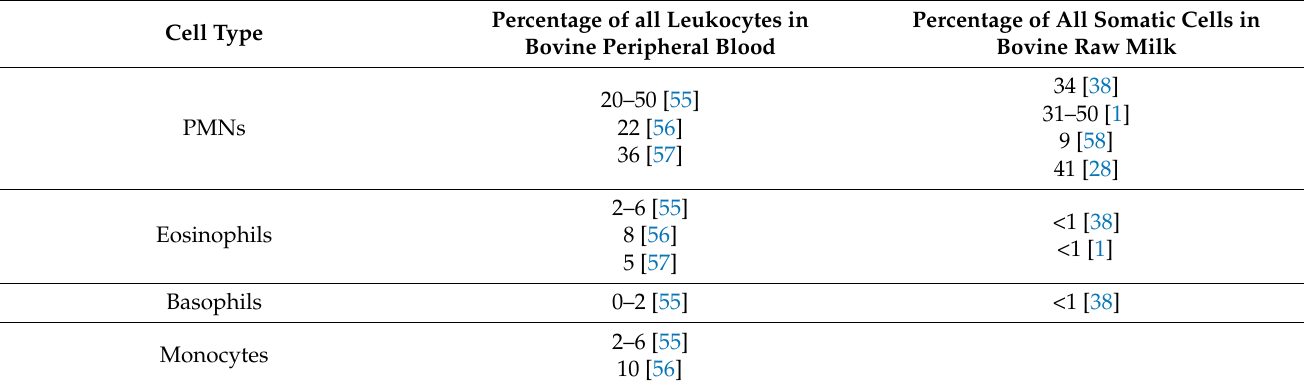
Table 2. Published data on the proportions of different cell types in peripheral blood and raw milk of healthy